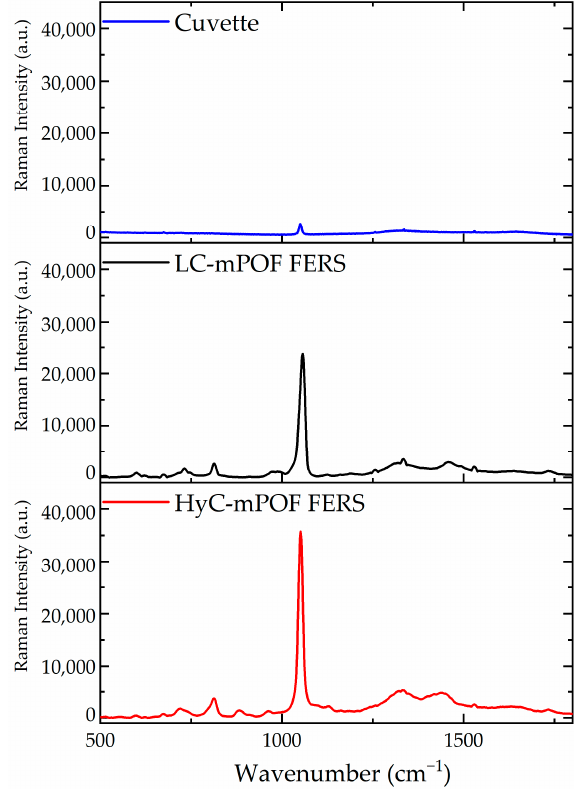
Figure 6. Comparison stack among cuvette (blue), LC-mPOF (liquid-core mPOF) (black) and HyC- mPOF (red) Raman measurements. In all cases, the Raman peak of the nickel nitrate is observed at 1050 cm − 1 but with different intensities.